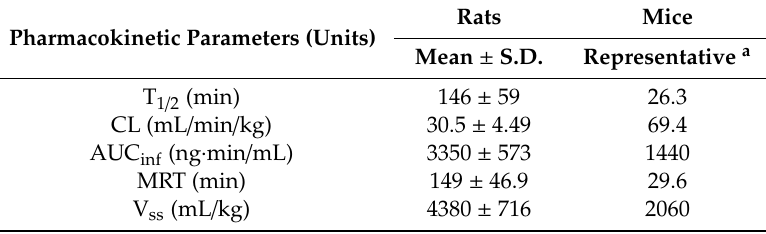
Figure 2. Mean concentration-time profiles of SH-1242 after ( A ) an intravenous injection of 0.1 mg / kg SH-1242 ( n = 4) to rats and ( B ) an intravenous injection of 0.1 mg / kg SH-1242 ( n = 3 for each time point) to mice. Results are presented as means ± standard deviations. Table 7. Pharmacokinetic parameters of SH-1242 after a single intravenous administration at a dose of 0.1 mg / kg to rats and